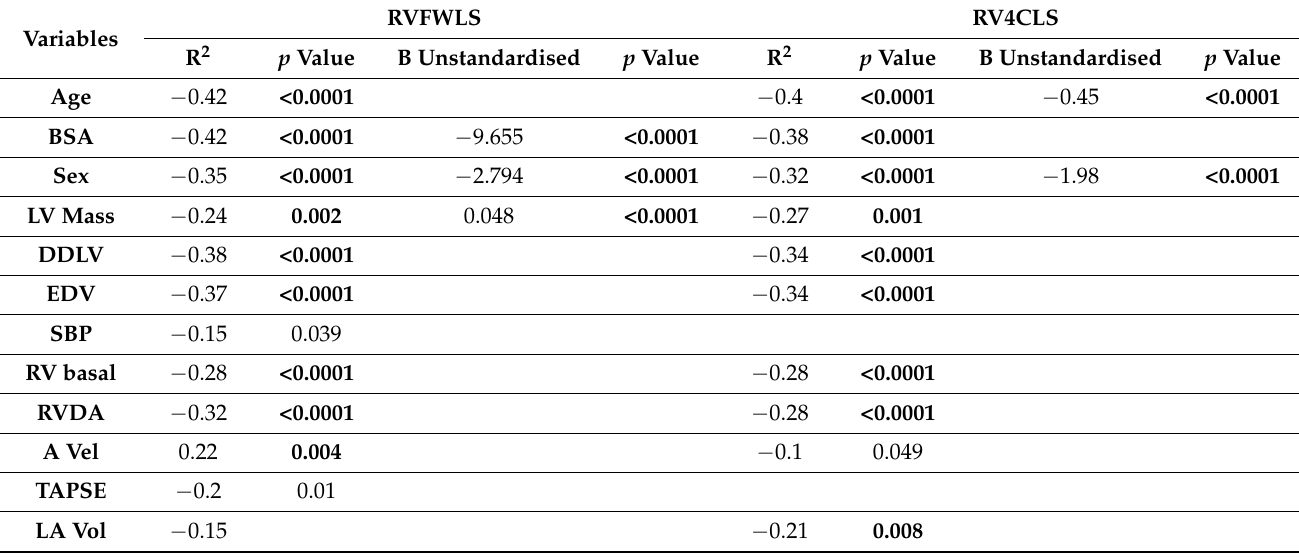
Table 8. The univariate and multivariate regression model results for right ventricle